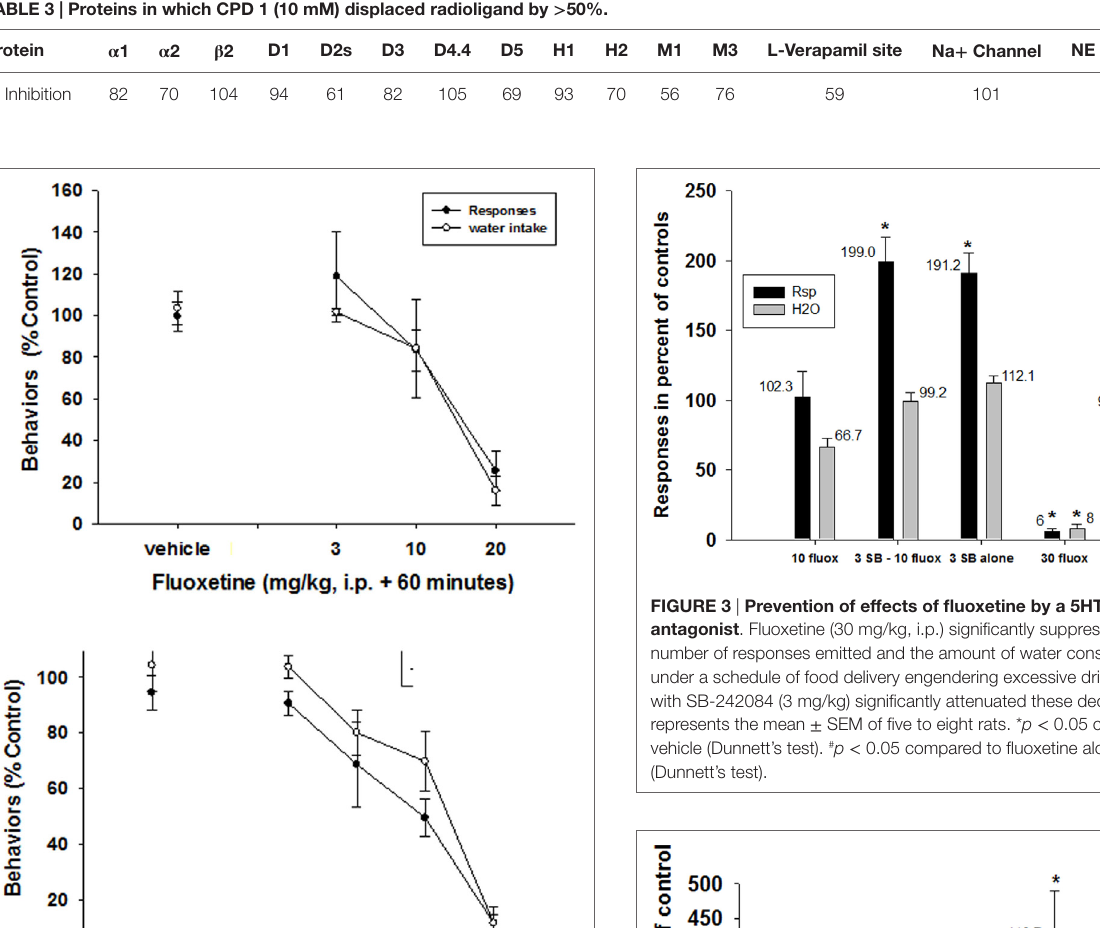
TaBle 3 | Proteins in which cPD 1 (10 mM) displaced radioligand by >